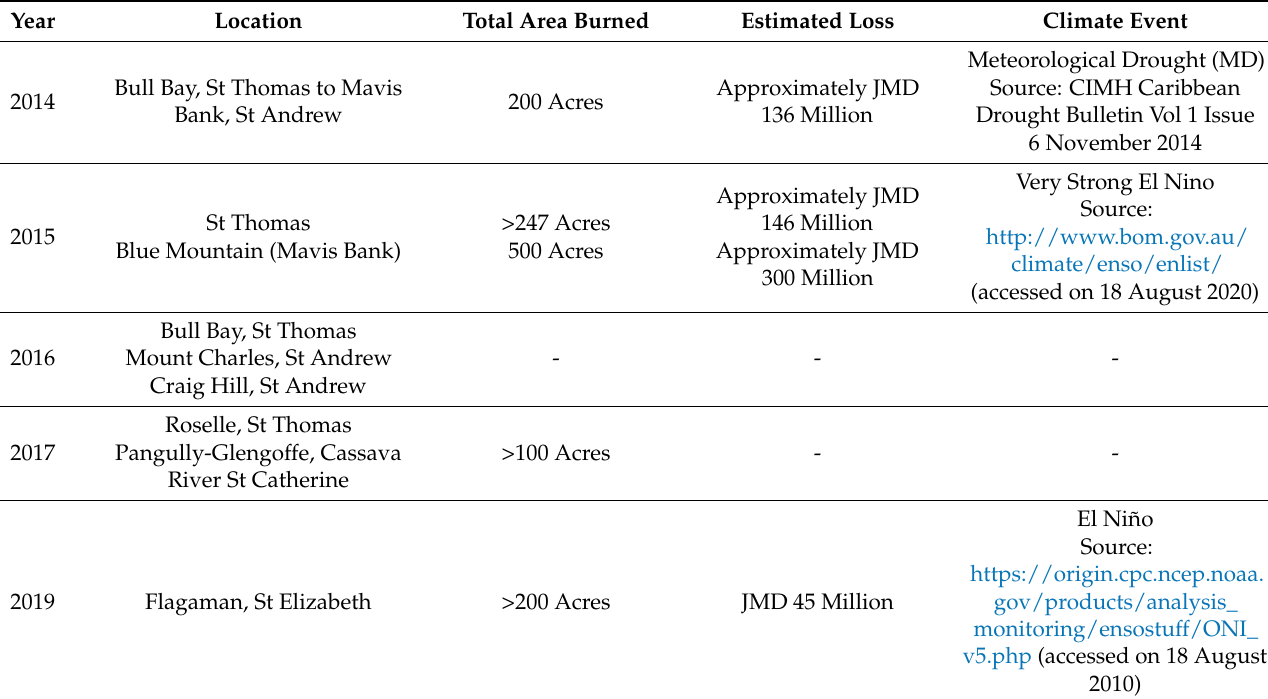
Table 1. Some bushfire events in Jamaica between 2014–2019 as reported by The Gleaner, the Jamaica Observer and Jamaica Information Service. The total area burned, estimated loss at time of reporting in Jamaica Dollars and the background climate event are also